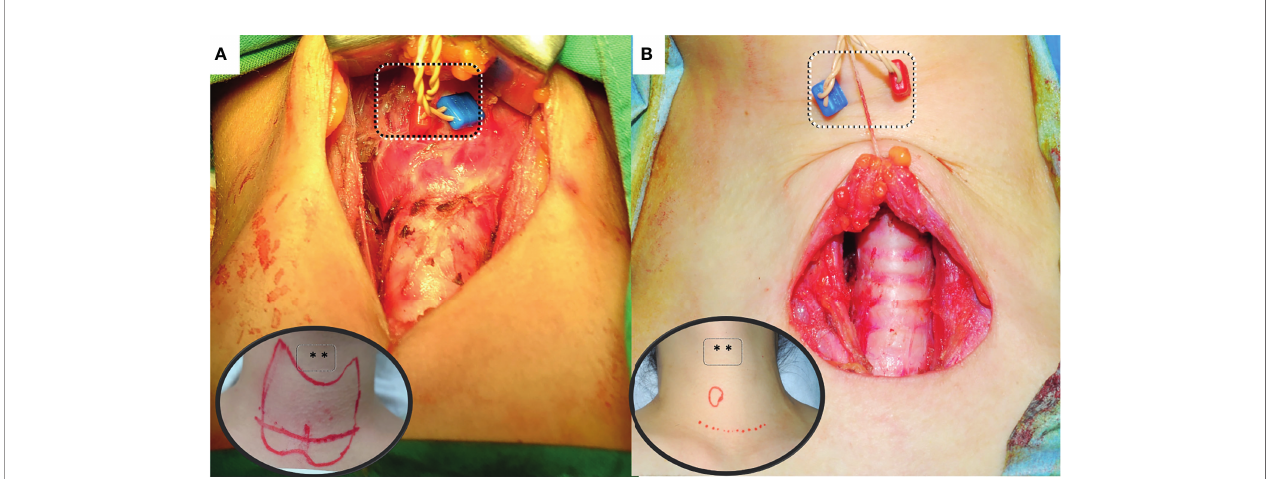
FIGURE 2 | Anterior laryngeal (AL) recording electrode placement for intraoperative neural monitoring. (A) Transcartilage Anterior Laryngeal Recording: Skin fl aps are elevated superiorly to expose the thyroid cartilage. Needle electrodes are placed onto the subperichondrium layer of thyroid lamina. Inserting the needle at the anterior margin of the thyrohyoid muscle with a 10- to 15-degree angle from the surface of lamina. (B) Percutaneous Anterior Laryngeal Recording: The needle electrodes are percutaneously inserted and fi xed onto the perichondrium layer of thyroid cartilage. It may be applied in surgeries with lower/smaller incision wound or in remote surgery. However, excessive traction may cause percutaneous needle displacement during the